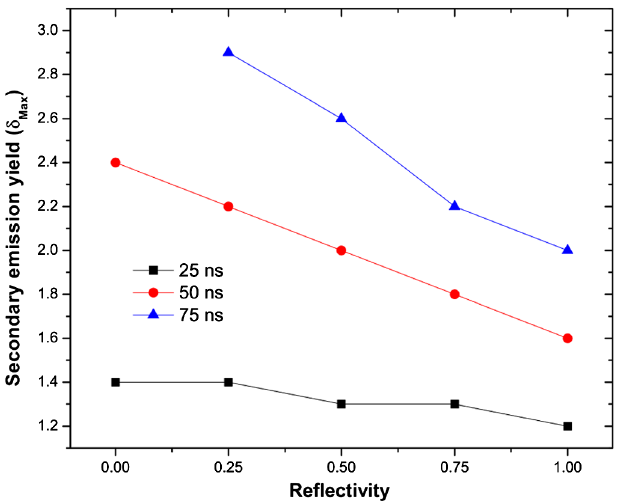
FIG. 27. Simulated multipacting thresholds for the LHC arc dipoles (chamber half apertures 22 (cid:2) 18 mm , magnetic field of 8.33 T, and an intensity of 1 : 15 (cid:2) 10 11 protons per bunch) as a function of electron reflectivity for three different values of bunch spacing at 3.5 TeV beam energy.